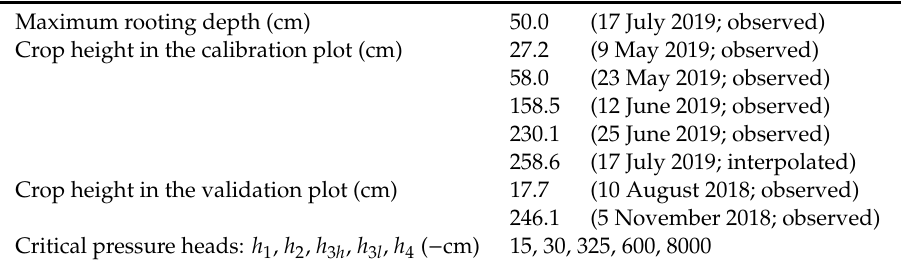
Table 3. Crop data used in the